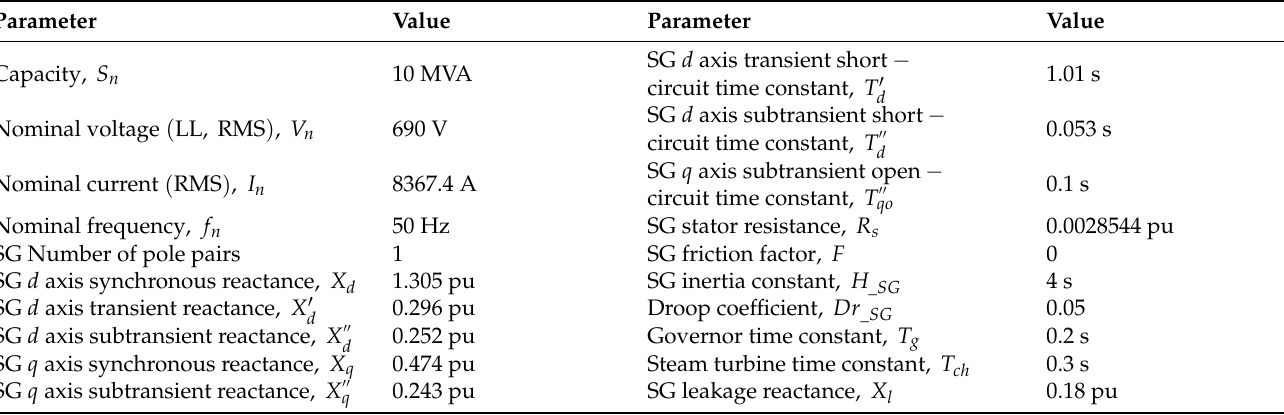
Table A6. Parameters of the